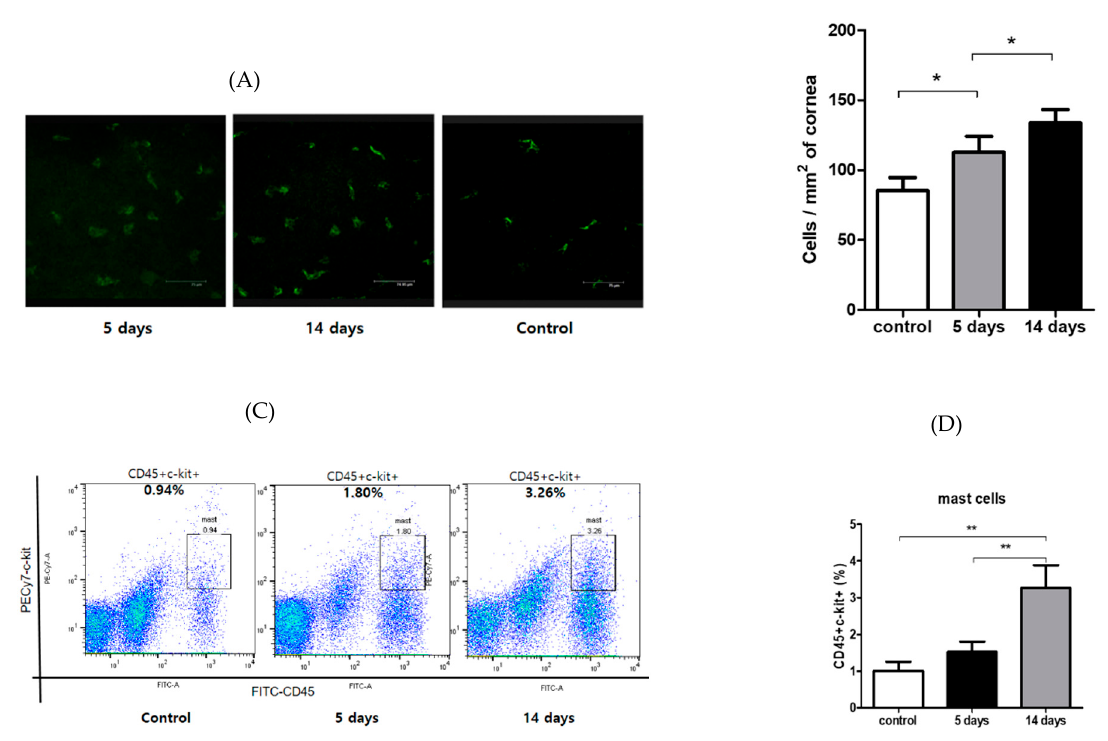
Figure 2. Inflammatory cells’ accumulation in the ocular surface in a murine model of traffic-related PM 2.5 exposure. ( A ) Representative epifluorescence images showing CD11b+ cells (green) in the central corneas (scale bar: 75 μ m). ( B ) Traffic-related PM 2.5 increased the number of CD11b+ cells in the central corneas, compared to the vehicle-treated groups. ( C ) Conjunctivae were harvested from these mice and the flow cytometry of mast cells (CD45+c-kit+) was analyzed. Figures represent three independent experiments. ( D ) Data are representative of three independent experiments. p -value signs indicate: * p< 0.05 , ** p < 0.001. Data are presented as the mean ± SEM of three experiments. Each experiment consisted of three to four corneas per group.